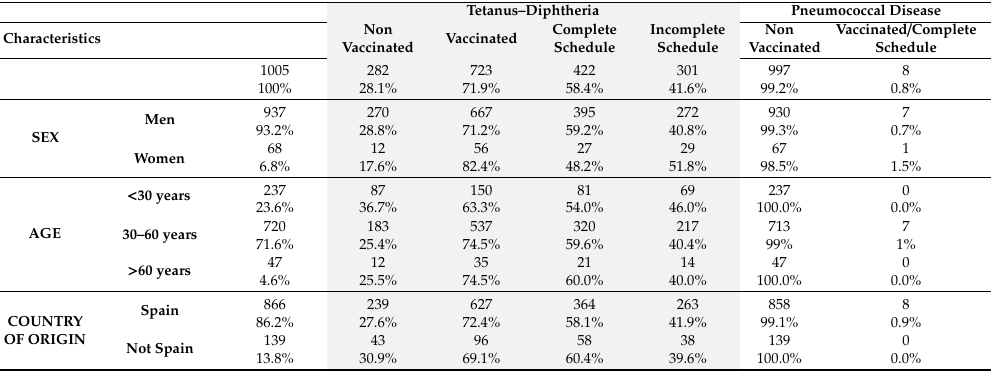
Table 3. Vaccination coverage against tetanus–diphtheria and Pneumococcal disease. Tetanus–Diphtheria PneumococcalDisease